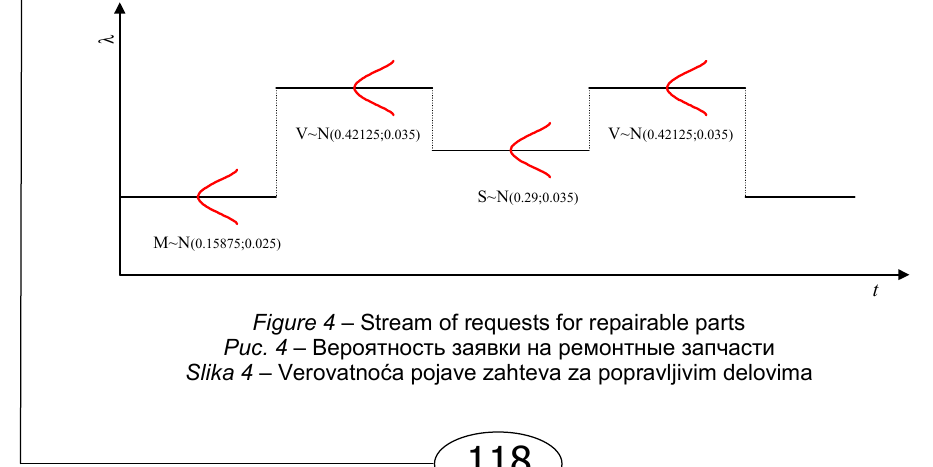
Figure 4 – Stream of requests for repairable parts Рис . 4 – Вероятность заявки на ремонтные запчасти Slika 4 – Verovatno ć a pojave zahteva za popravljivim